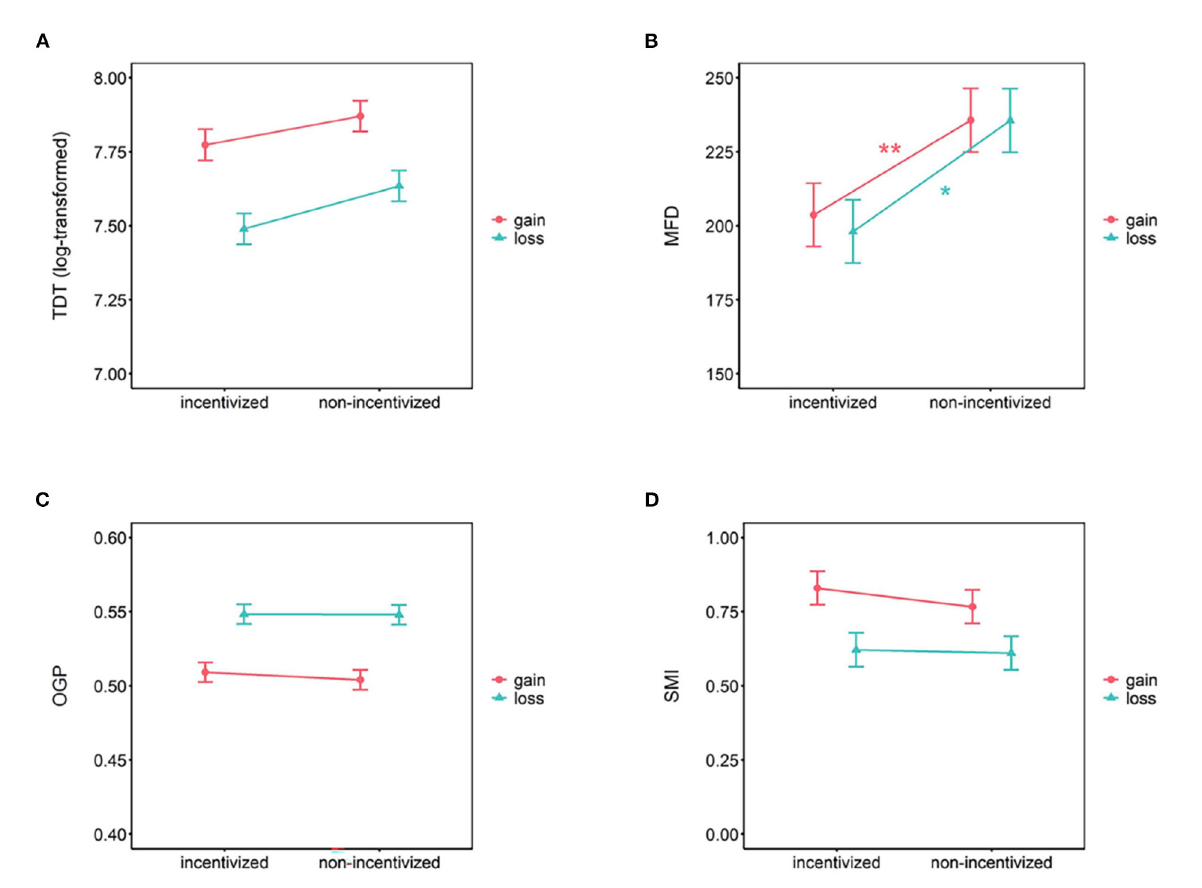
FIGURE3 Eye-tracking measures results of (A) TDT, (B) MFD, (C) OGP, and (D) SMI in the present study. Error bars represent 95% CI. ∗ p < 0.05, ∗∗ p <